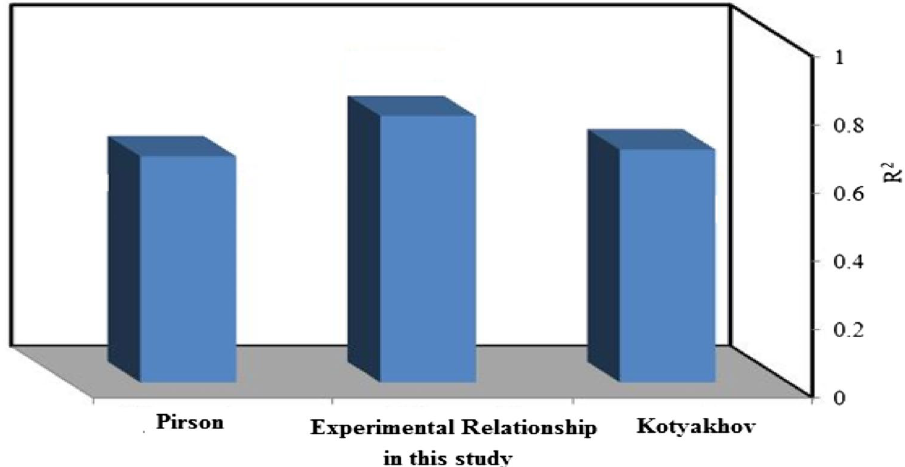
Fig. 15 Summary of compari- son of correlations and different models (Kotyakhov 1949; Pirson